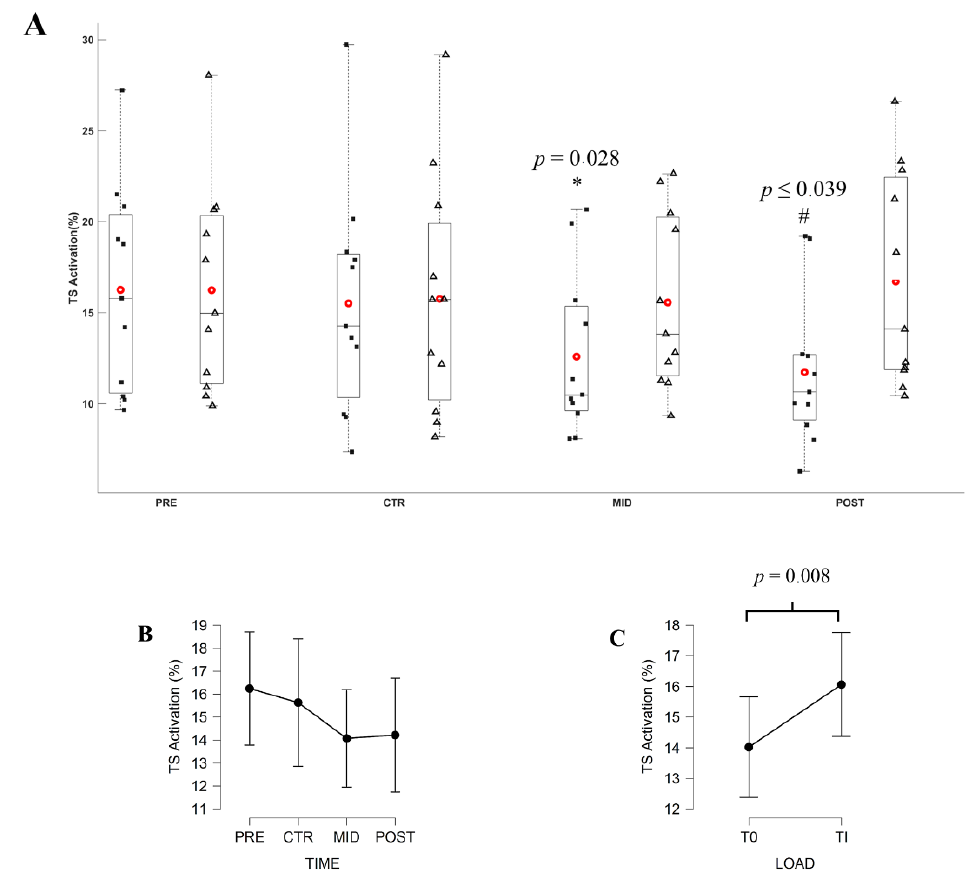
Figure 7. ( A ) Average EMG TS during submaximal contractions computed according to the torque levels, T 0 (black square) and Ti (white triangle), and evaluation sessions (PRE, CTR, MID, POST sessions). Each whiskers box indicates the mean (red circle) and the median (horizontal line). The inferior and superior edges of the box indicate the 25th and 75th percentile, respectively. Black dots represent individual participant performance. ( B ) Average EMG TS during submaximal contractions computed according to evaluation sessions and ( C ) to the torque levels. Error bars represent the most extreme and non-outlier data points ( A ) and 95% confidence intervals ( B , C ). * Significant difference in comparison to Ti torque level recording at MID evaluation. # significant difference in comparison to T 0 and Ti torque level respectively recorded at PRE and POST evaluation.